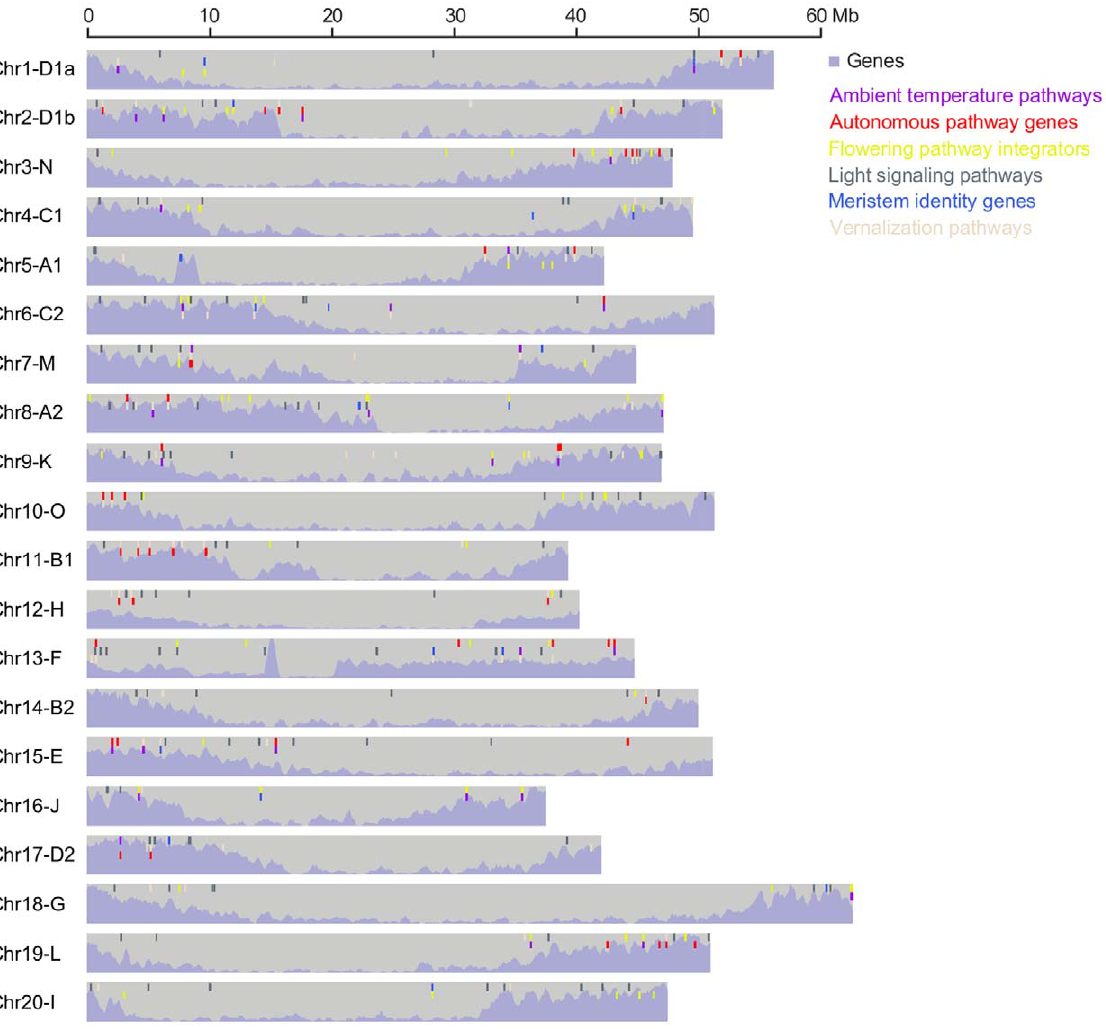
Figure 3. Genomic loci of soybean genes homologous to Arabidopsis floral regulatory genes. Soybean genes in Table 1 that are homologous to Arabidopsis floral regulatory genes are indicated with solid bars of different colours while the purple shade represents gene density. These soybean genes are randomly spread over the whole genome. Gene density depiction is adapted and modified from Figure 1 by Schmutz et al . (2010) [10].